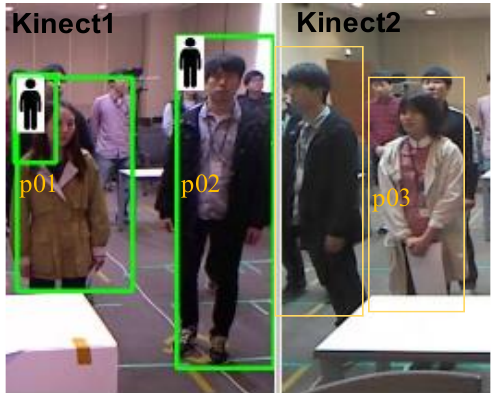
Fig. 7: WHERE fusion keeps only 1 detected human instead of two human staying near the border of two